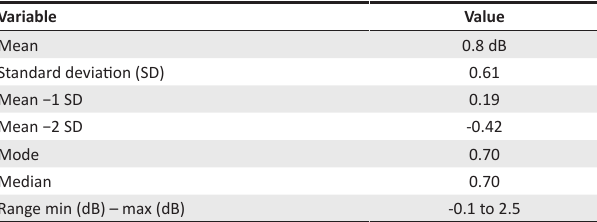
TABLE 4: Contralateral acoustic stimulation suppression (dB) from normal ears ( n = 40).